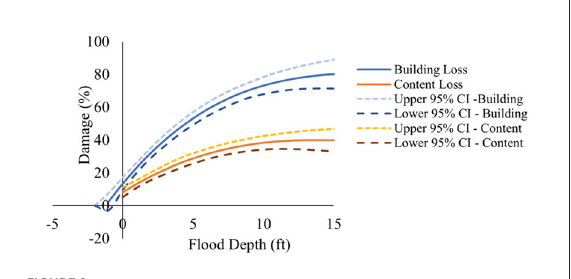
FIGURE2 USACE (2000) DDF for a one-story home without